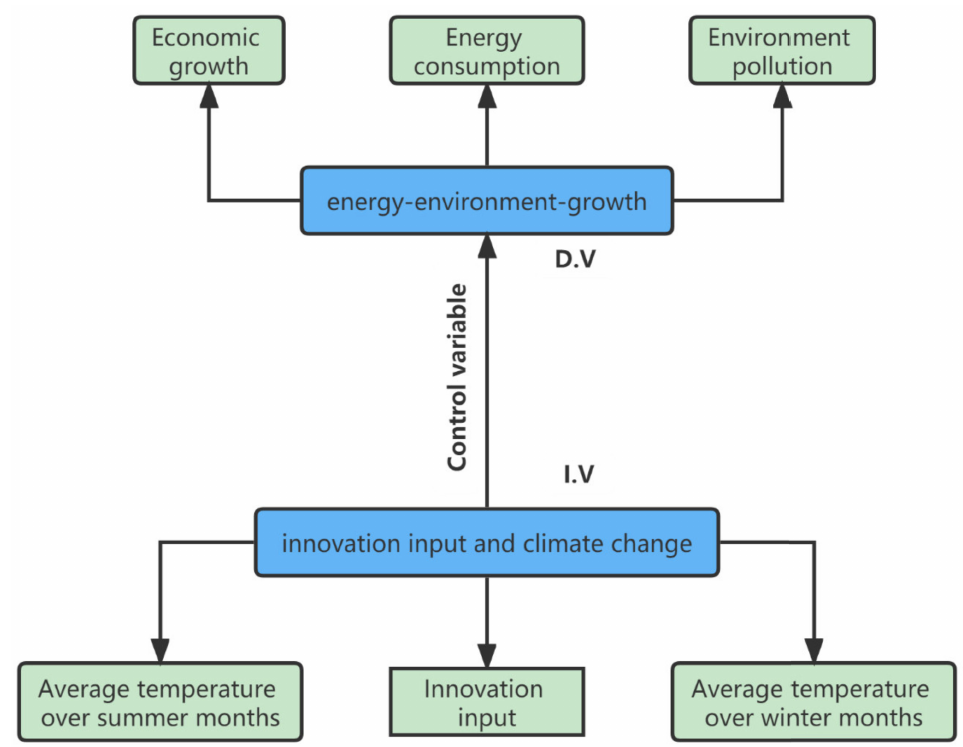
Figure 1. Conceptual